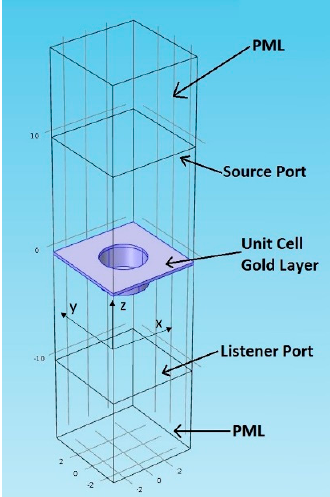
Figure 2. A schematic diagram of the numerical simulation model. Only a unit cell of the plasmonic crystal structure is simulated considering the periodicity of the two dimensional array.